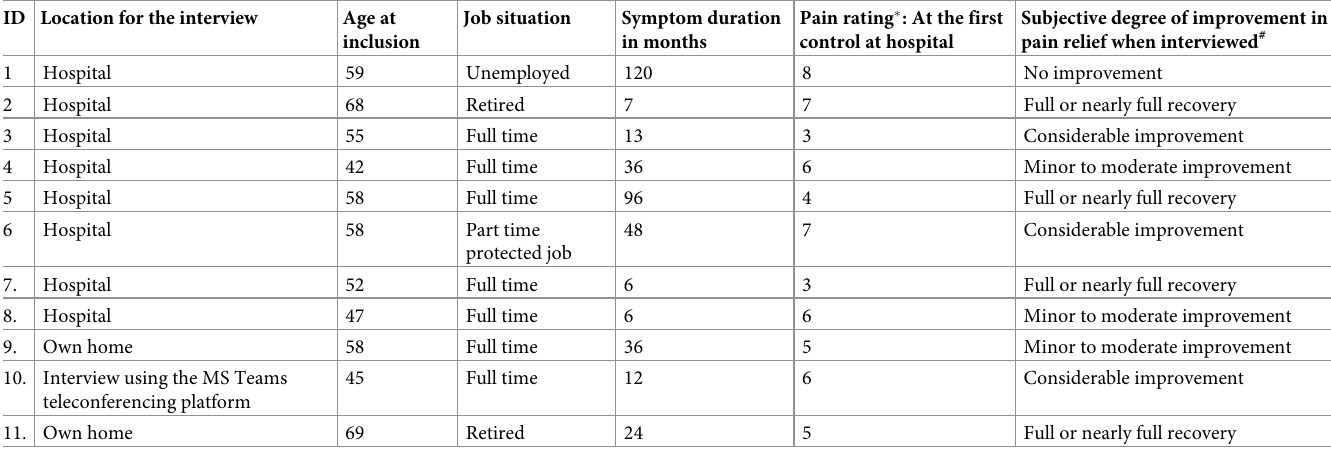
Table 2. Participant characteristics, N =